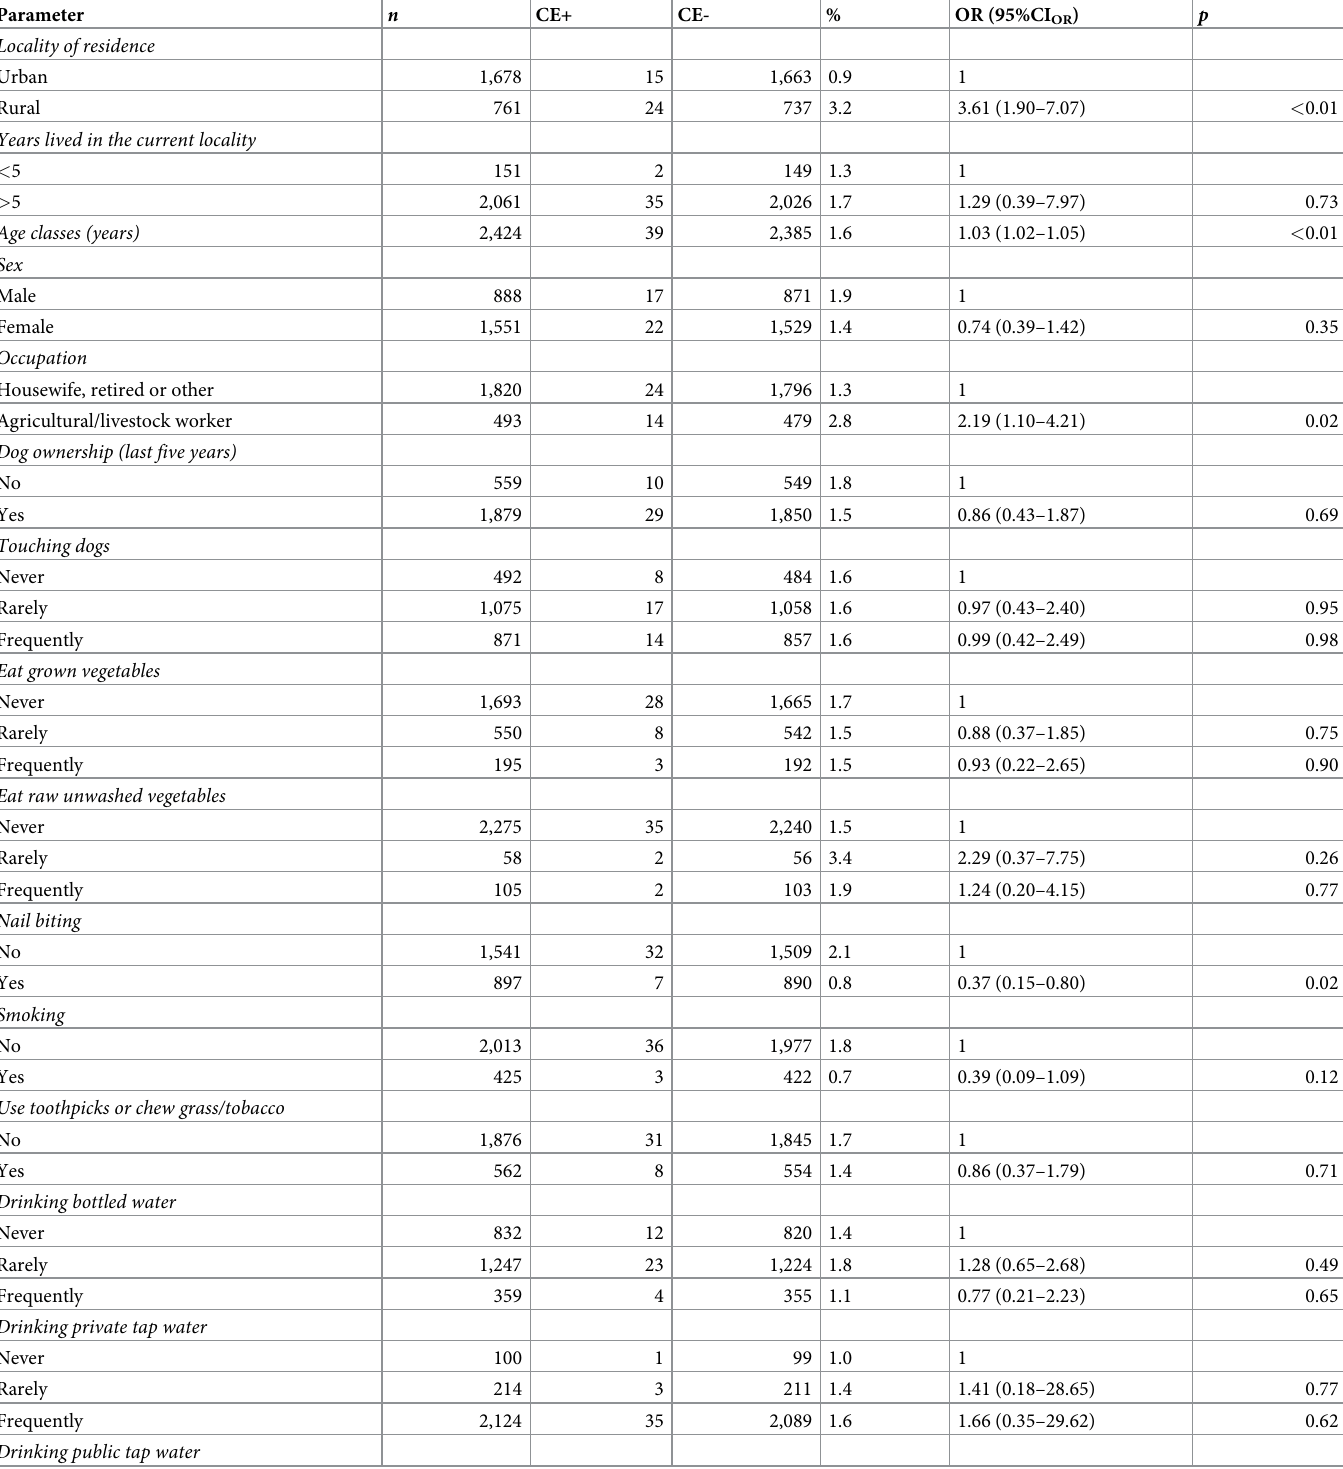
Table 2. Univariate risk factors for abdominal cystic echinococcosis in screened subjects from localities of the Monte Patria municipality, Limarı´province, Coquimbo region, Chile.